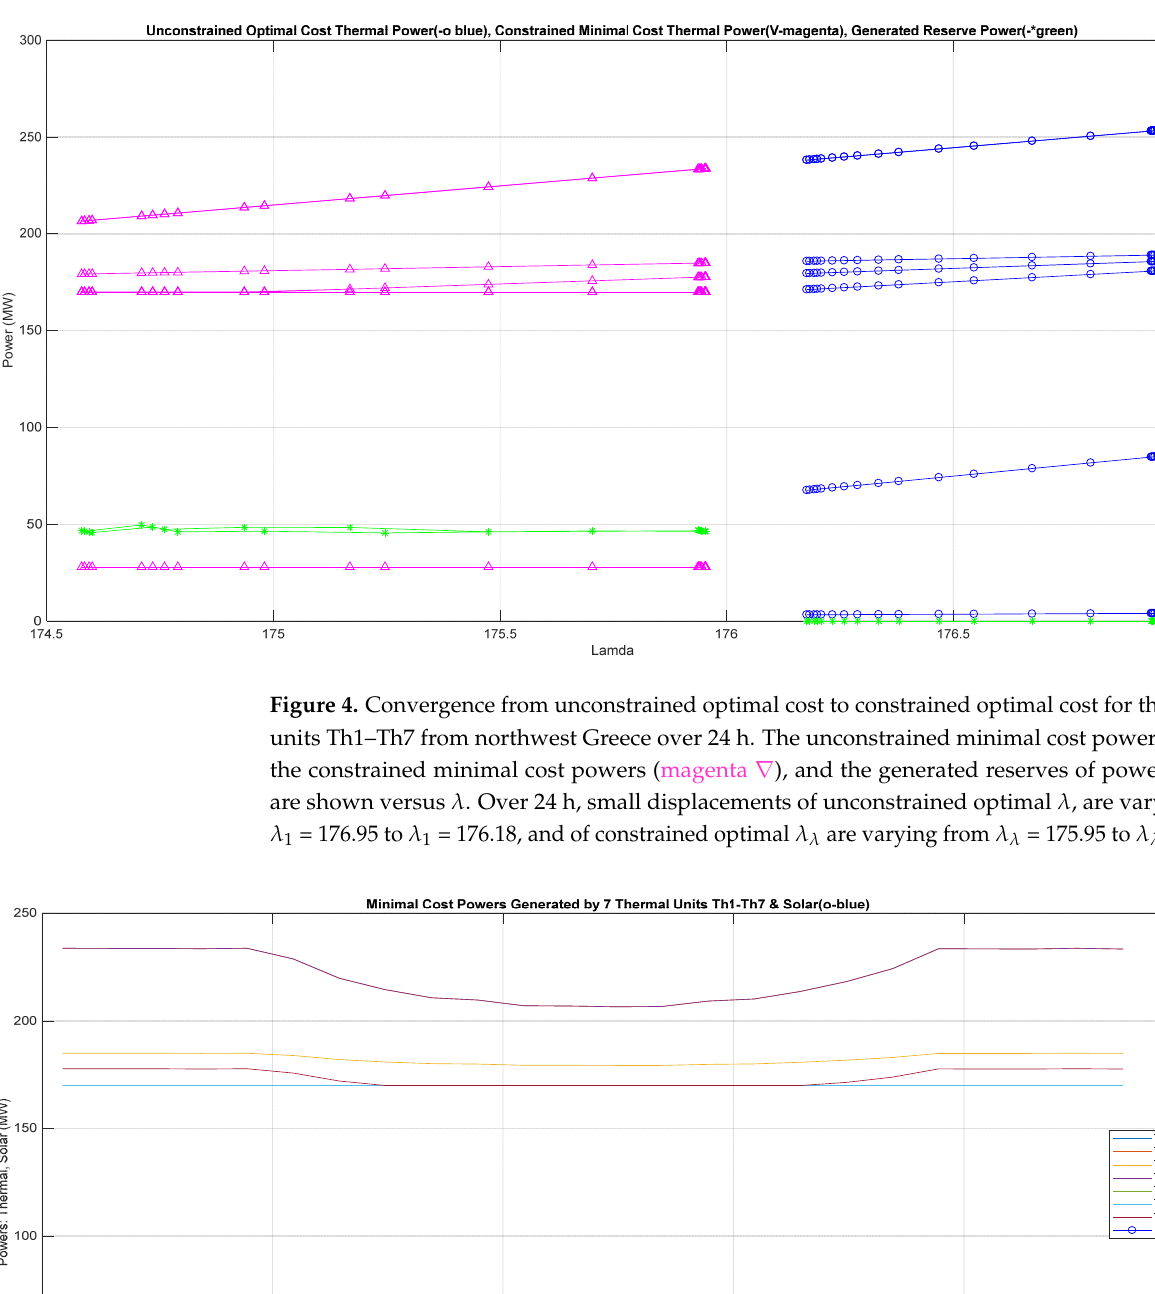
Figure 3. Cost rate functions versus generated power of seven thermal units from northwest Greece.